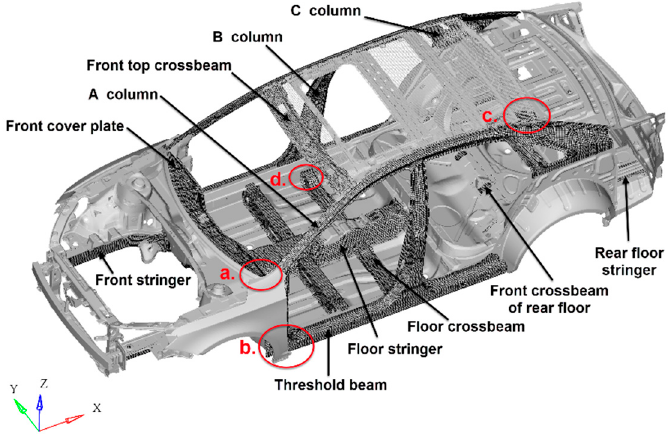
Figure 10. Main force-transmitting components in a typical BIW.